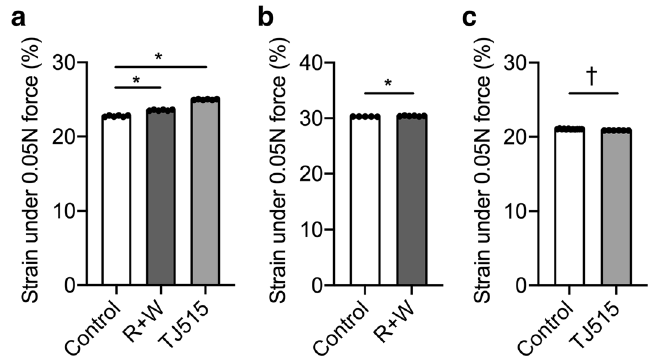
Figure 2. The effects of treatment with resveratrol and WB2000 together or TJ515 alone on rat lens elasticity. ( a ) Male rats (12-week-old) received the represented supplements alone or in combination by daily oral administration for 40 weeks. After the treatment period, rat lenses were extracted and their elasticity was measured (n = 6 in each group). The percentages of strain for the three groups (two treatment and one control) when the lenses were pushed with 0.05 Newtons (N) of force are shown in the bar graph. ( b ) The effects of short- term treatment with resveratrol and WB2000 on rat lens elasticity. Male rats (5-week-old) received resveratrol and WB2000 (R+W) in combination (n = 6) or the vehicle (control; n = 5) by daily oral administration for four weeks. After the treatment period, rat lenses were extracted and their elasticity was measured. The percentages of strain when the lenses were pushed with 0.05 newtons (N) of force are shown in the bar graph. ( c ) The effects of short-term treatment with TJ515 on rat lens elasticity. Male rats (5-week-old) received TJ515 (n = 6) or vehicle (control; n = 12) by daily oral administration for three weeks. After the treatment period, rat lenses were extracted and their elasticity was measured. The percentages of strain when the lenses were pushed with 0.05 newtons (N) of force are shown in the bar graph. Data are presented as mean ± SEM. The asterisk and dagger indicate statistically significant difference compared to each control (*, † P < 0.05, one-way analysis of variance